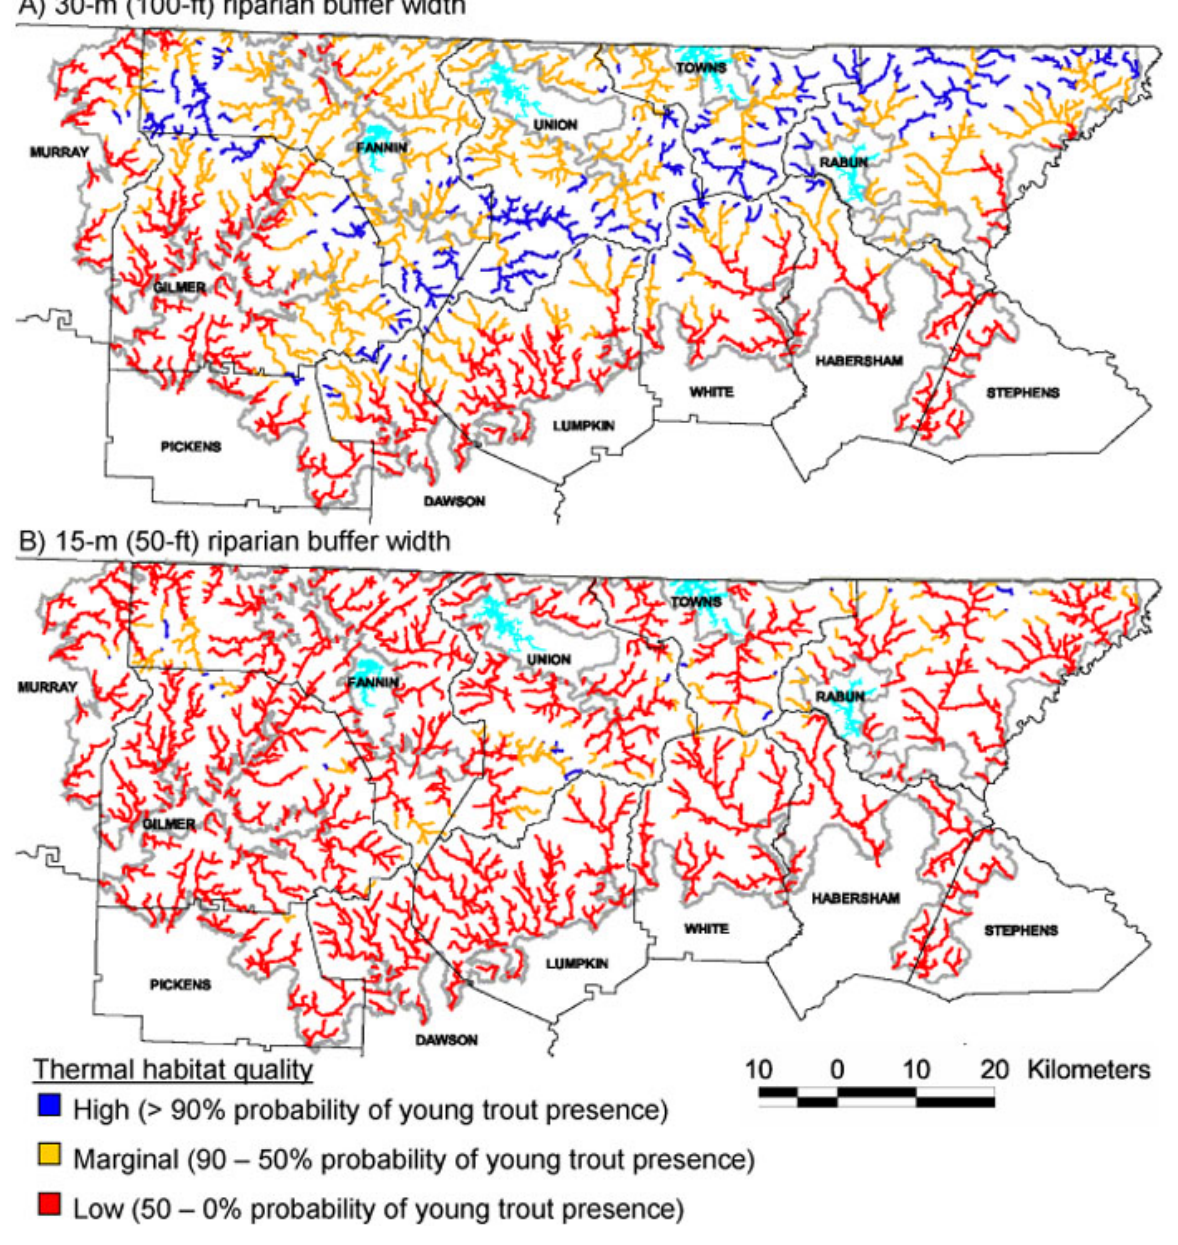
Fig. 11. Distribution of streams by thermal habitat quality if upstream riparian buffer widths were: A) 30 m; or B) 15 m. Thermal habitat quality was classified from the logistic regression in Fig. 8. This figure is not intended as a scenario; all streams across north Georgia are not expected to have uniform 15-m wide buffers simultaneously. It is intended to show the approximate distribution of individual stream segments apt to maintain the temperature conditions necessary for trout populations if bordered by a 30- m or 15-m wide riparian